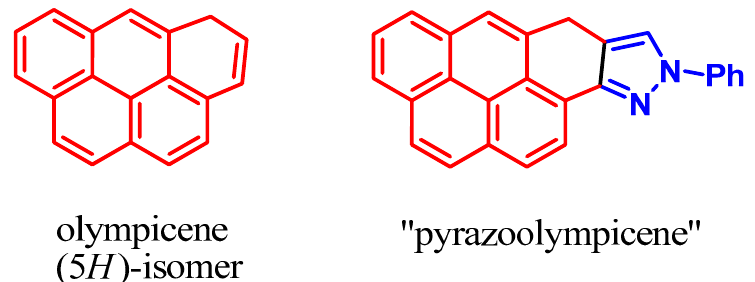
Figure 3. Molecular structure of compound 3 , determined by X-ray diffraction. As expected, unlike the highly twisted molecules of 1 [21], the molecules of 3 were found to be planar (Figure 4 and Supplementary Information). Figure 4. Overlay of the X-ray diffraction-derived structures of 3 (blue) and 1 (red). The mechanism proposed by Klumpp [26] suggests that compounds 3 and 4 may be formed by the disproportionation of alcohol, 5 , which is the presumed initial cyclization product, and thus obtained in equivalent amounts. However, we found that 3 tended to undergo partial oxidation to 4 on workup. As a result, the isolated yields of 3 and 4 were different and not strictly reproducible (15–25% for 3 and 70–80% for 4 ).